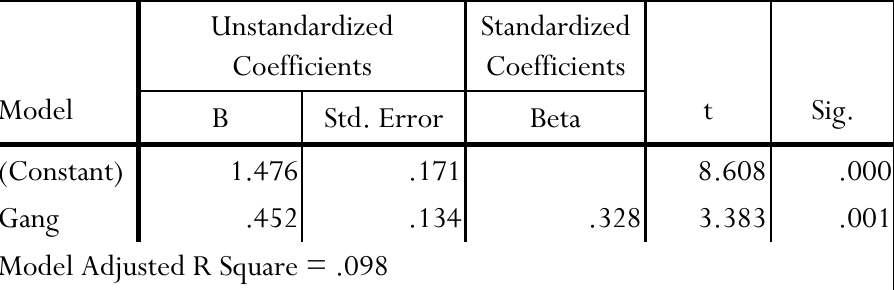
Table 17: Linear Regression of Number of Victimizations on Duration of Running